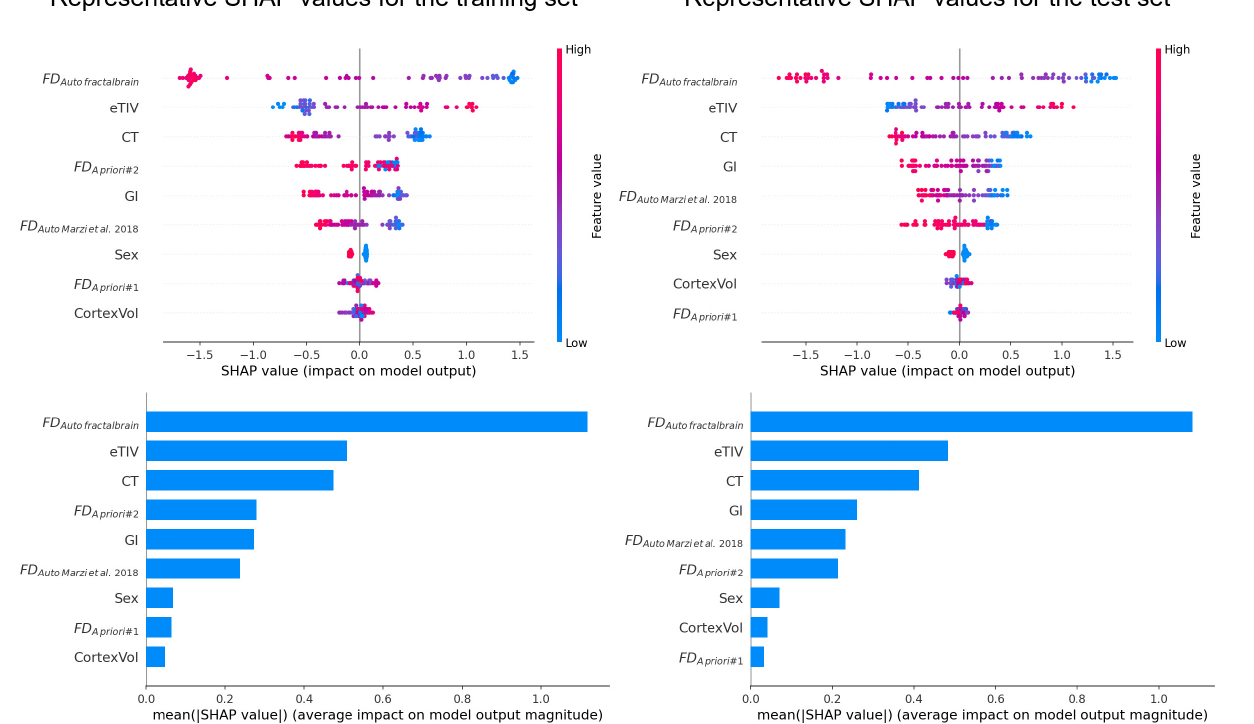
Figure 3. Results for the NKI2 regression task in a 5-fold nCV over 100 repetitions. Top row: beeswarm summary plots of representative SHAP values for the training (on the left ) and test sets (on the right ). The given SHAP explanation is represented by a single dot on each feature row for each sample (i.e., subject). The SHAP value of each feature determines the x position of the dot, and dots pile up along each feature row to show density. Color is used to display the original value of the feature. Bottom row: summary bar plot representing global feature importance as represented by the mean absolute SHAP value for that feature over all the given samples for the training (on the left ) and test sets (on the right